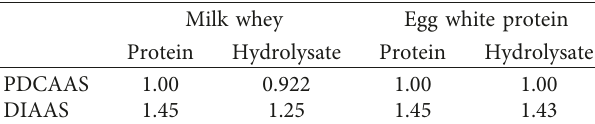
Table 5: PDCAAS and DIAAS in rats fed protein or hydrolysate of milk whey or egg